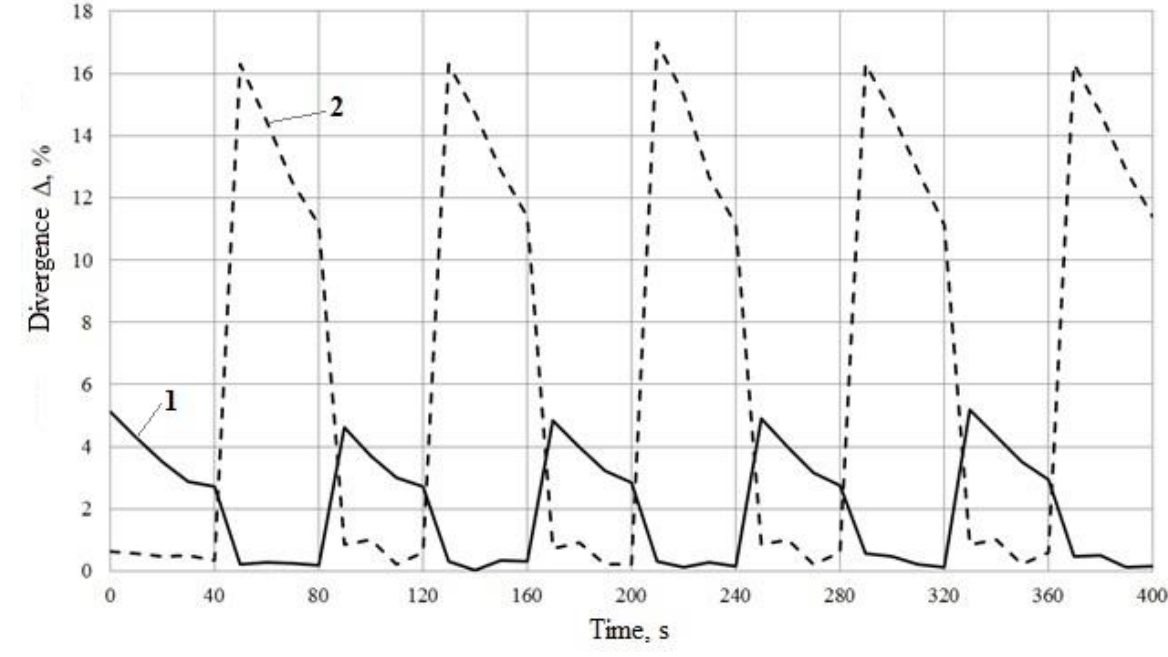
Figure 10. Percentage deviation of the calculated data from the experimental data on the change in air temperature at the ends of the SSRHE: 1: inner end; 2: outer end.